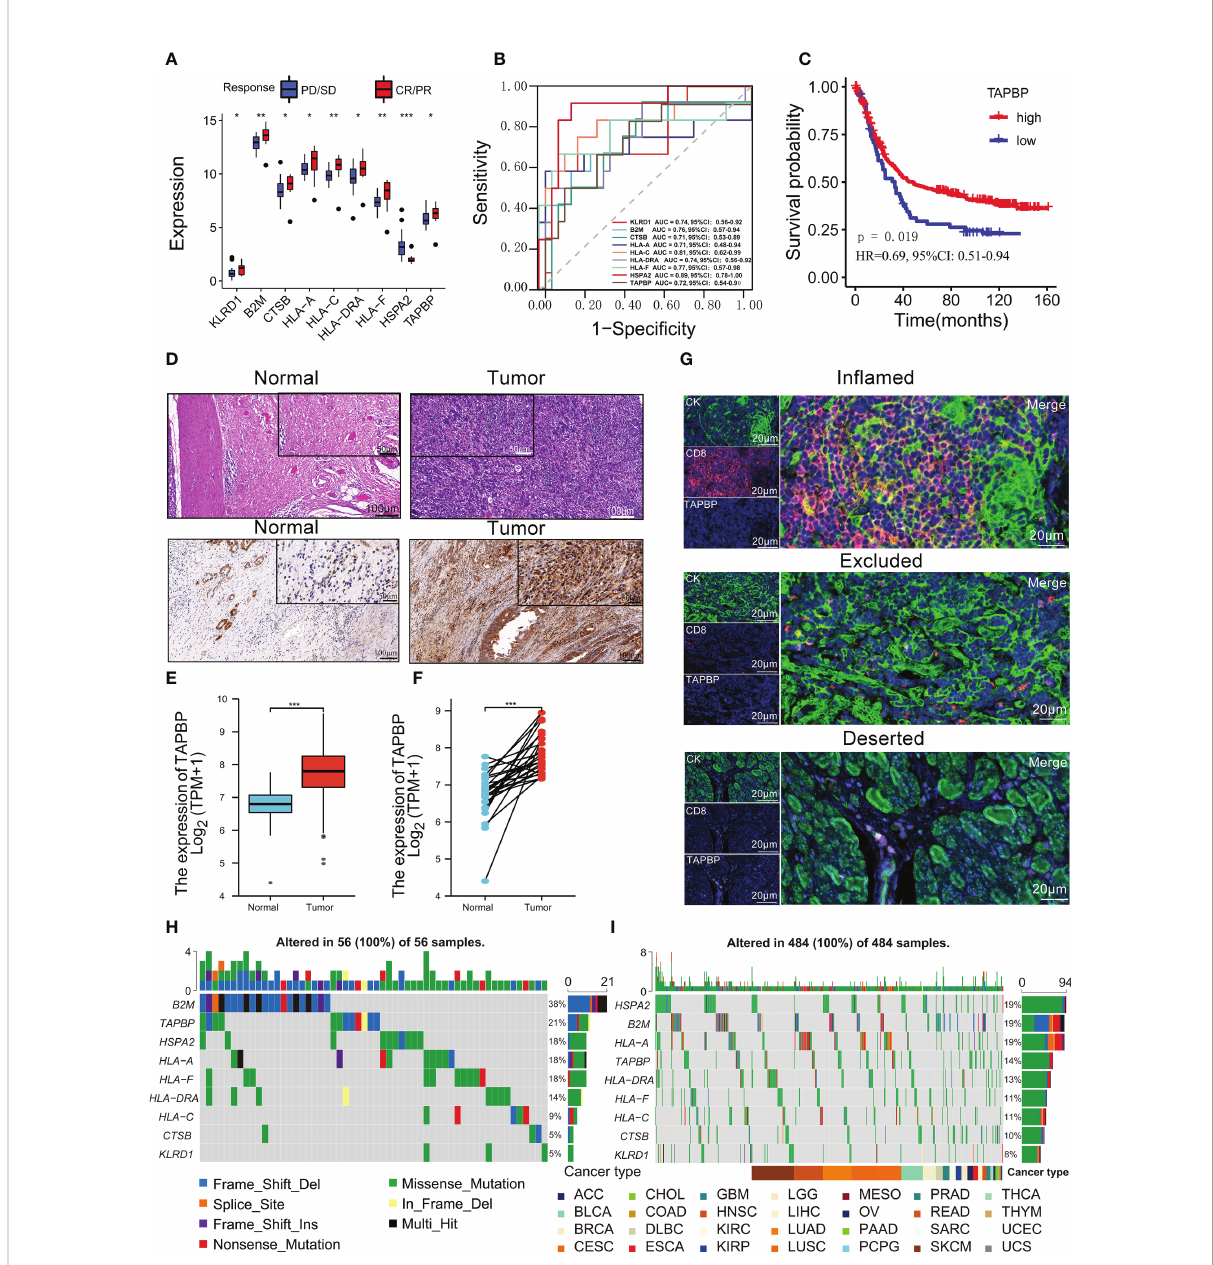
FIGURE 6 TAPBP was related to the immunotherapy response and the tumor immune microenvironment. (A) Comparison of nine predictive model genes between CR/PR group and SD/PD group in the Kim cohort. (B) ROCs for nine genes predicting immunotherapy response in the Kim cohort. (C) The Kaplan-Meier survival curves between the Kim cohort ’ s high-TAPBP expression group and the low-TAPBP expression group. (D) HE and IHC staining results in tumor and normal tissues in GC. The expression of TAPBP in between tumor tissues and normal tissues (E) or adjacent normal tissues (F) from the TCGA-STAD cohort. (G) The multi-color fl uorescence staining detected the spatial distribution of TAPBP and CD8 in the immune-in fl amed subtype, immune-excluded subtype, and immune-deserted subtype of GC. The distributions of nine predictive model genes somatic alterations from TCGA-STAD cohort (H) and pan-cancer TCGA cohort (I) . Asterisks denote signi fi cant differences (*p< 0.05; **p< 0.01; ***p<